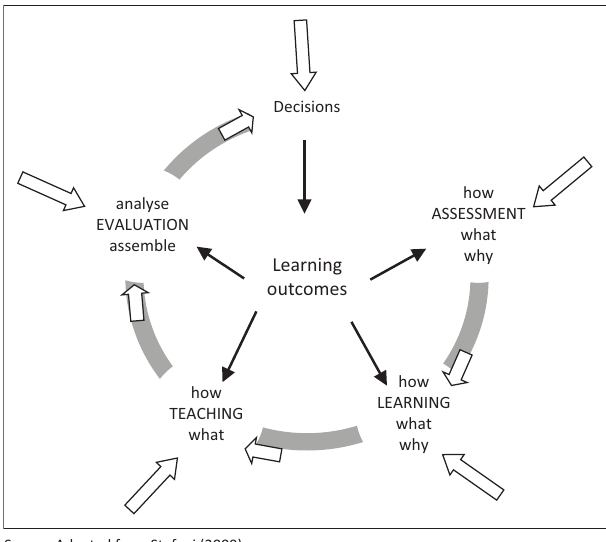
FIGURE 1: A typical process model of programme